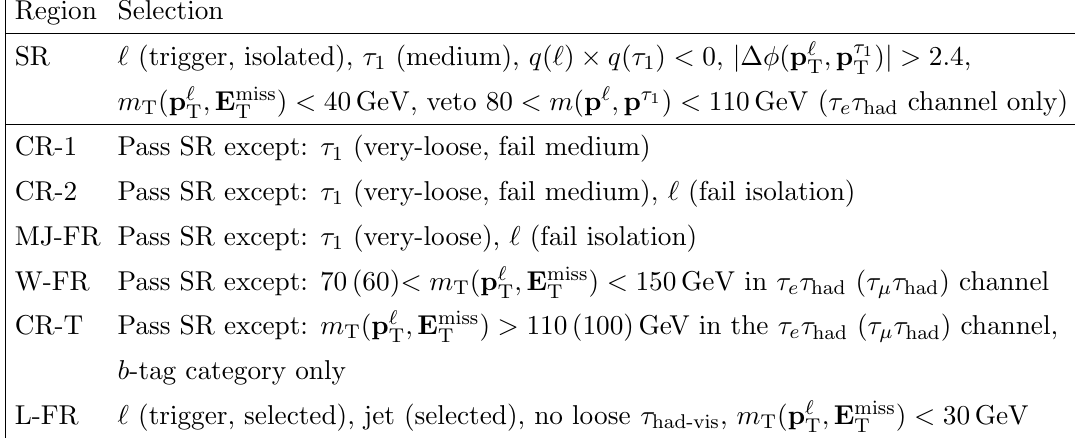
tau fake-factor ( f